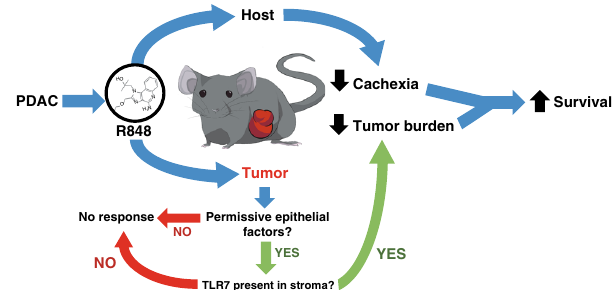
Fig. 8 Graphical summary of fi ndings. We fi nd that in murine models of PDAC, R848 acts on both host and tumor to promote bene fi cial survival responses. In host, we observe decreased manifestations of cachexia by behavioral and molecular metrics. In tumor, we observe that dependent on whether epithelial cells recruit R848-sensitive stroma, TLR7 stimulation mediates anti-tumor responses including increased T-cell in fi ltration and cytotoxic activity. These factors converge to extend survival in